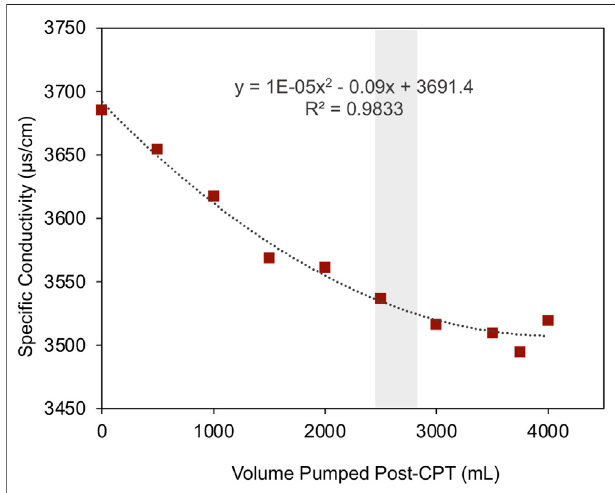
FIGURE 4 | Speci fi c conductivity decreased rapidly immediately following the end of the localized cone penetrometer activity including during the addition of the bentonite slurry (gray bar) in CPT 43, 47, and